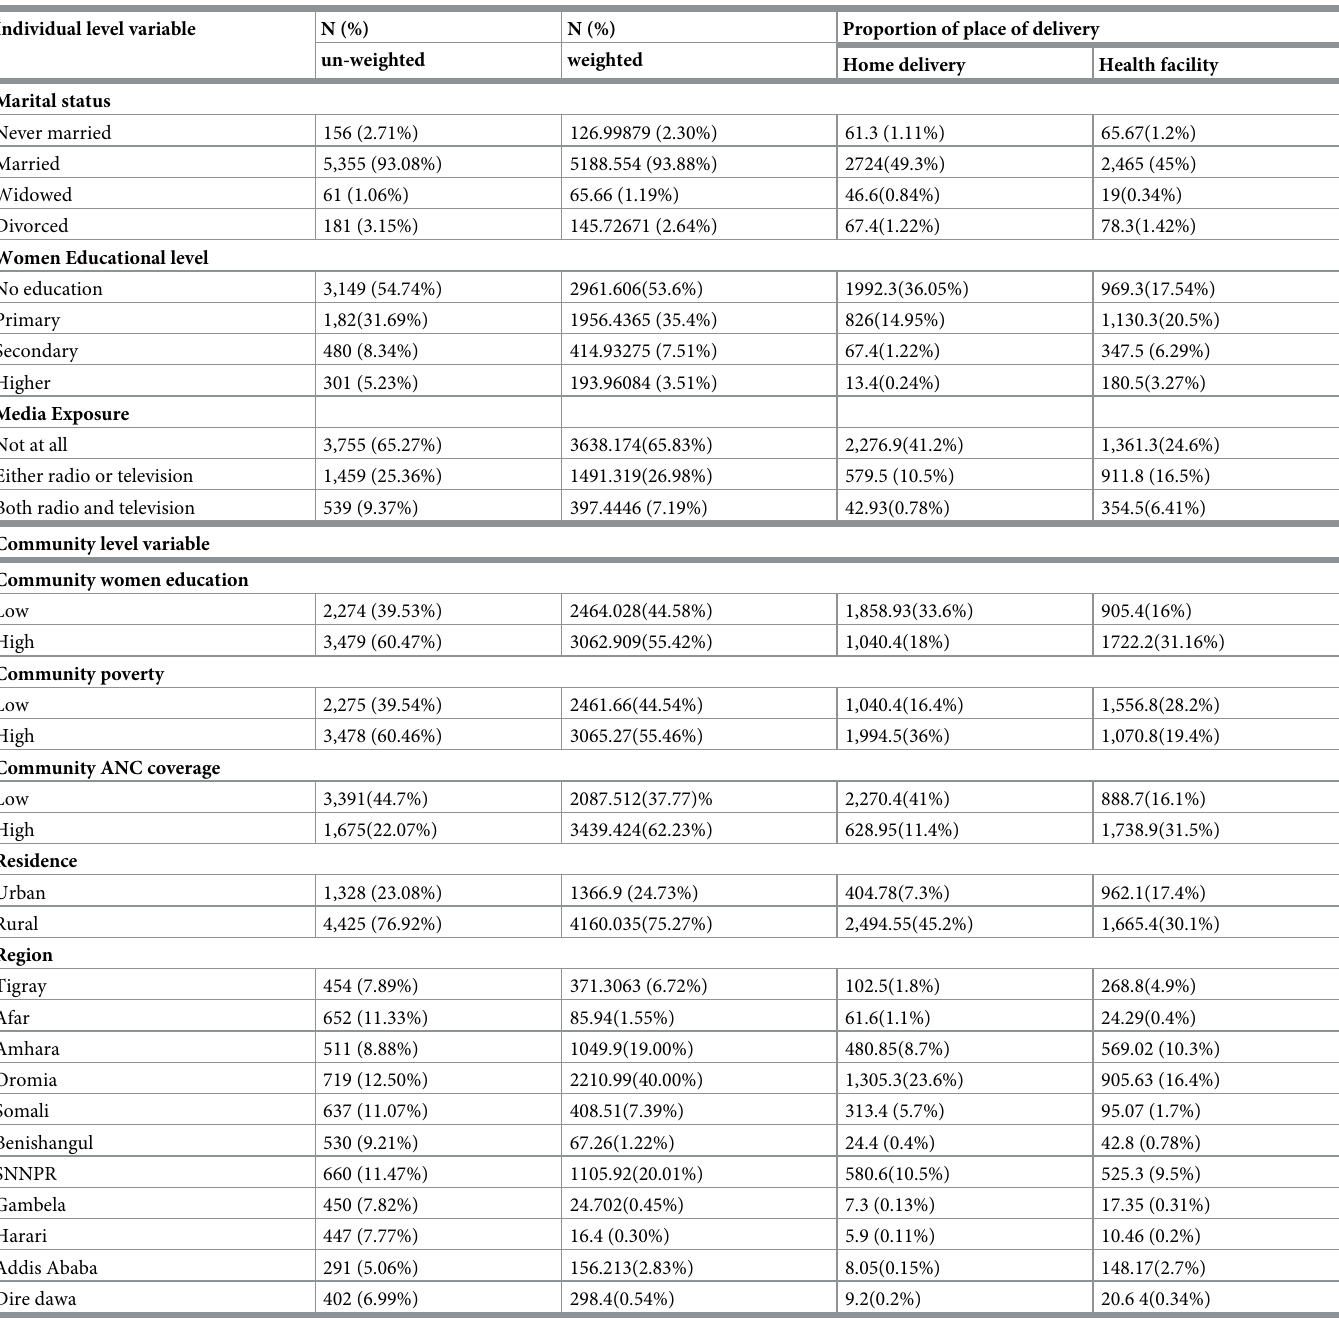
Table 1. Individual and community level characteristics of women who had live births in the last five years preceding (EDHS) 2019, Ethiopia. Individual level